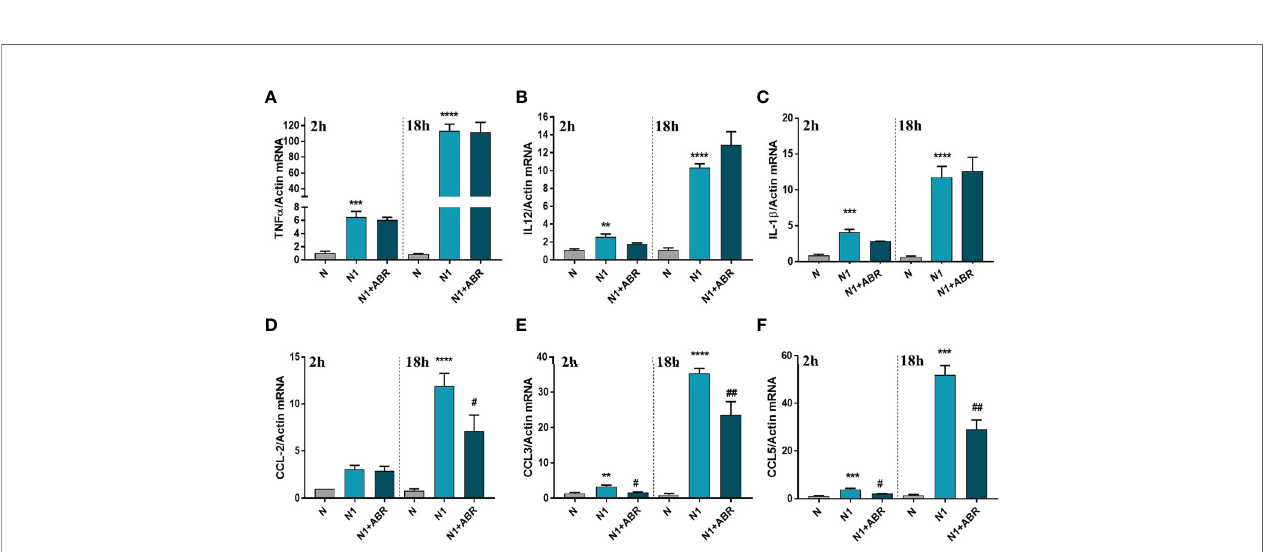
FIGURE 3 | The effect of S100A9 blockade on gene expression of immune mediators (A – F) in neutrophils exposed to LPS+IFN g (N1) or IL-4 (N2) in the presence of ABR-238901 (ABR). The treatment decreases signi fi cantly the gene expression of CCL2, CCL3 and CCL5 in N1 neutrophils at both 2h and 18h. n = 3; **p < 0.01, ***p < 0.001, ****p < 0.0001 (N1 vs N); # p < 0.05, ## p < 0.01 (N1+ABR vs N1).